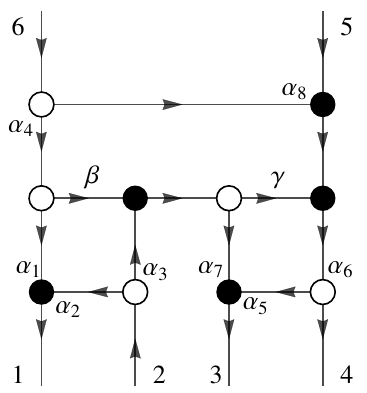
Figure 12 . The 4+4 channel BCFW diagram contributing to the 6 point NMHV amplitude in N = 4 SYM. Edge variables are denoted as (cid:11) i . The labels (cid:12) and (cid:13) are not edge